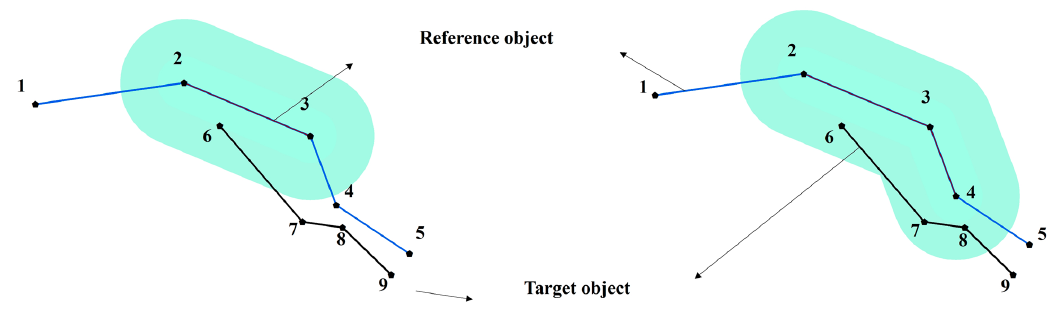
Fig. 2. Buffer growing for road linear objects